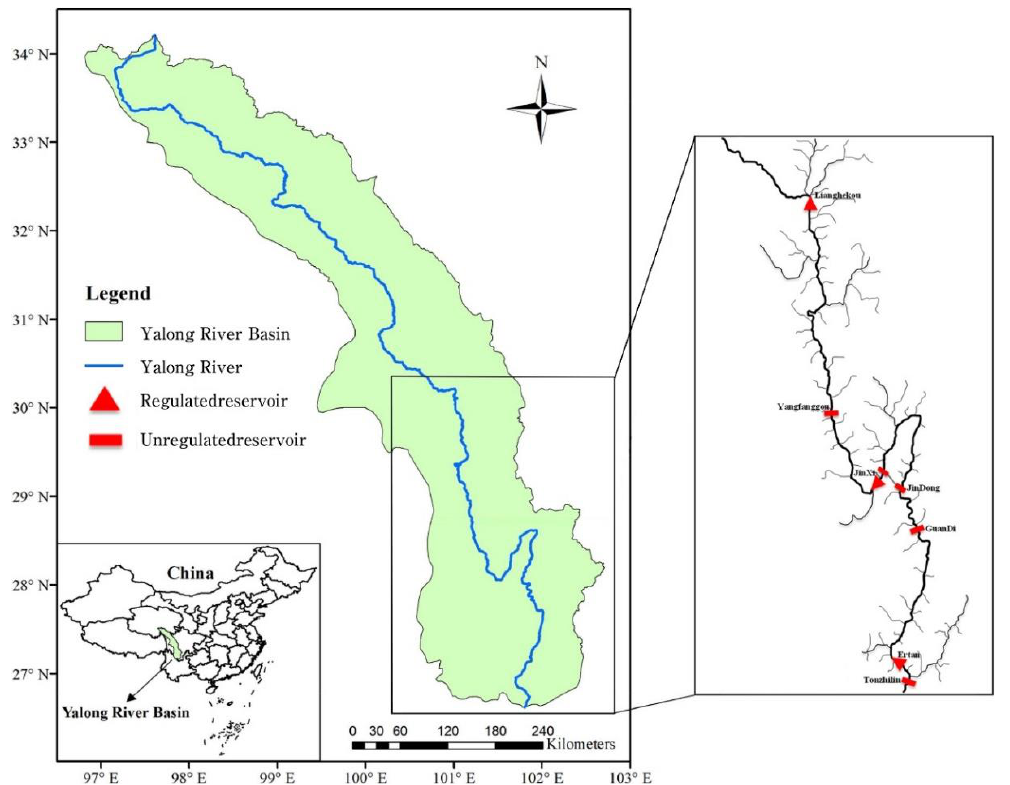
Figure 3. Location of the cascade reservoirs in the Yalong River Basin. Table 1. Characteristic parameters of the Yalong River cascade reservoirs.